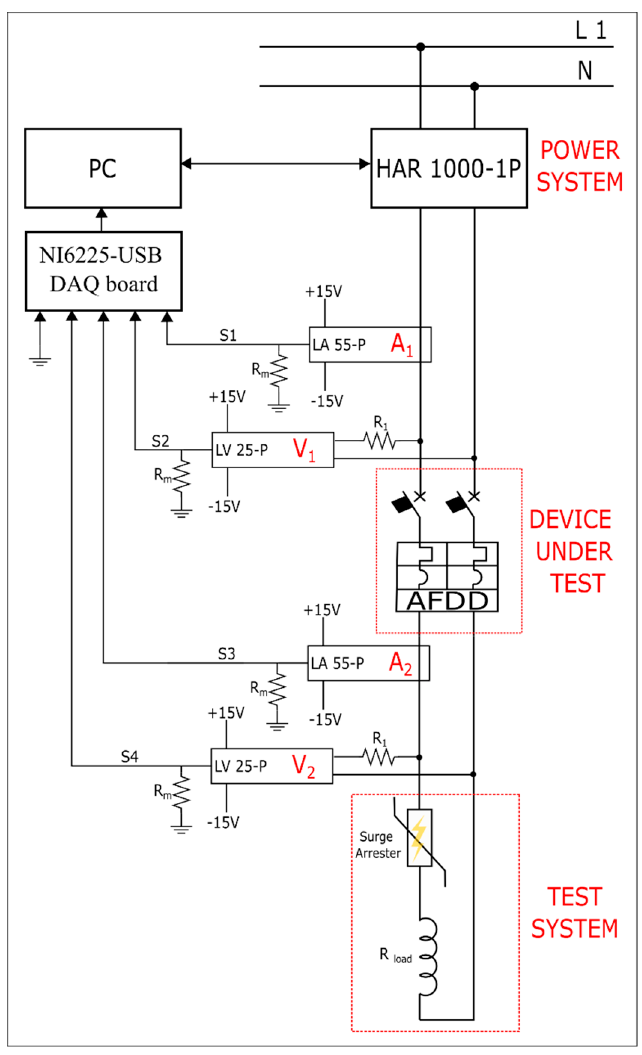
Figure 3. Scheme of the AFDD test platform. DAQ: data acquisition.